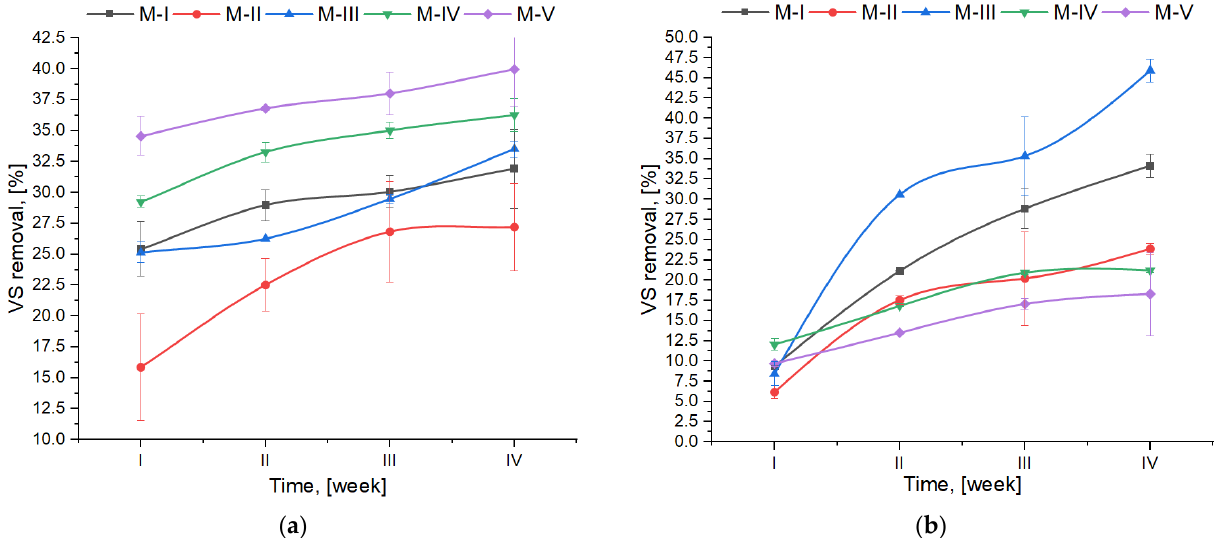
Figure 3. VS. removal: ( a ) mesophilic temperature; ( b ) thermophilic